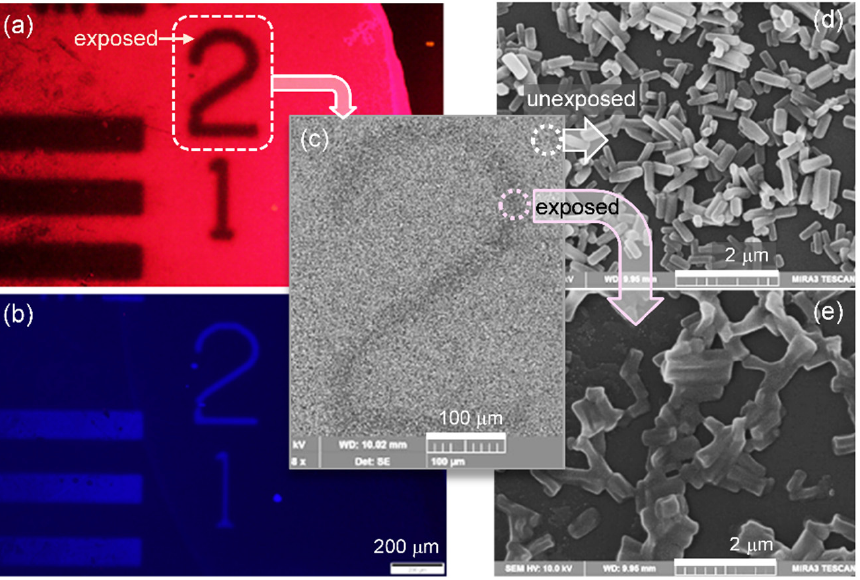
Figure 8. Hexagonal rods placed on quartz substrate were covered with photomask and exposed to UV light. FOM images ( a : excited with green light, b : excited with UV light) of pattern information recorded on hexagonal rods. ( c ) SEM image with number 2 recorded. ( d , e ) Magnified SEM images taken before and after irradiation with light through photomask. The rods exposed to light partially melted.